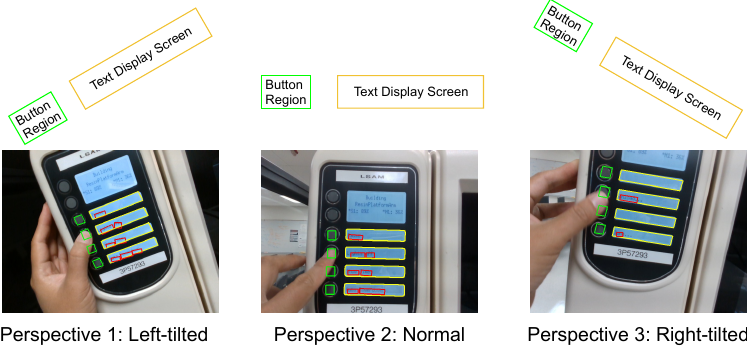
Figure 5. Processed camera frames from different visual perspectives.